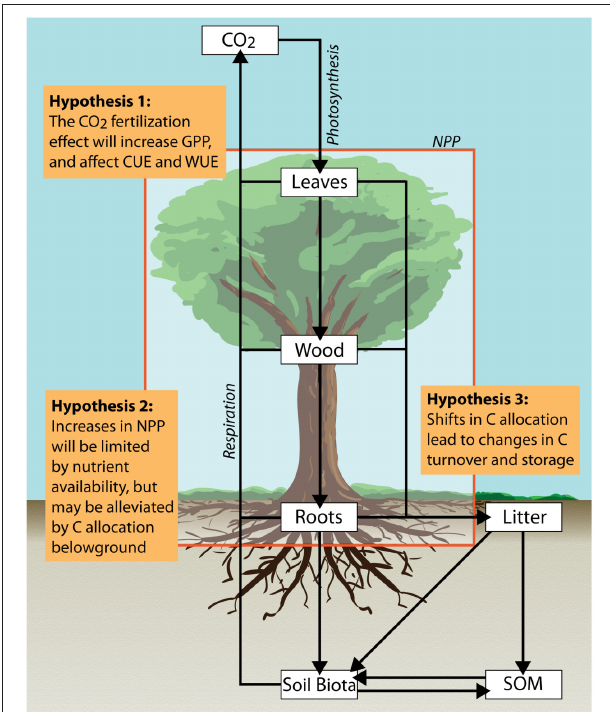
FIGURE 1 | Simplified conceptual model depicting major pools and fluxes of carbon in tropical forests. Assumption-based hypotheses to be targeted by the proposed Amazonian long-term ecosystem experiments are discussed in the